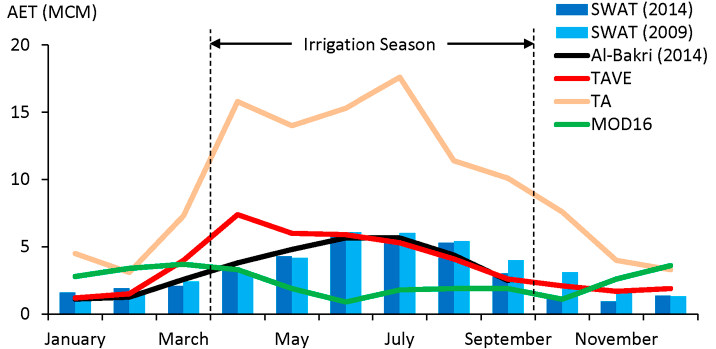
Figure 9. Comparison of monthly AET estimates over the Yarmouk River Basin using TAVE, TA, MOD-16, and SWAT. The red line represents 2009 TAVE monthly estimates. The black line shows the estimated irrigation water consumption in 2014 from a local study [48]. Shown as bars are monthly AET estimates based on SWAT simulation results for 2009 (light blue) and 2014 (dark blue). The dashed black lines show the duration of the irrigation season from April to September for major crops. AET is in million cubic meters (MCM).